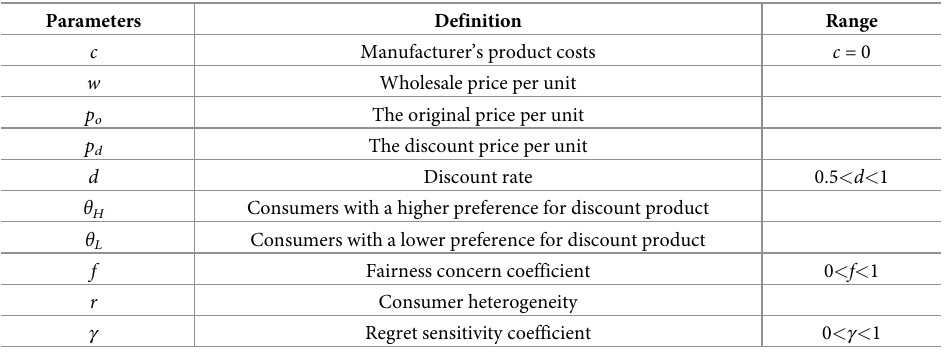
Table 1. Parameters and